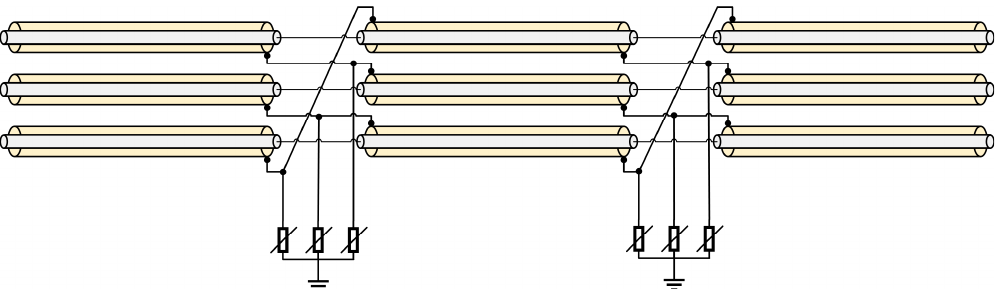
Figure 6. UGC with sectionalized cable sheath cross-bonding .